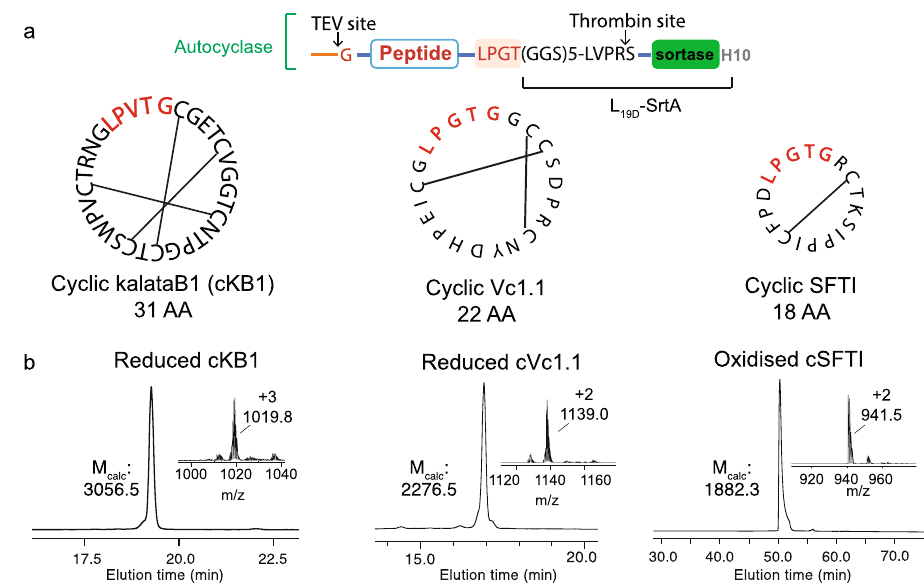
Fig. 4 The production of three different cyclic peptides from autocyclases. a The design of the autocyclases used for producing cyclic SFTI, kalataB1 (kB1) and Vc1.1. The native peptide sequences are shown in black, with lines indicating the disul fi de bond connectivity. The SrtA recognition sequence (LPXTG) that remains in in the peptide after the cyclisation is highlighted in red. b The identity and purity of the cyclised peptides were assessed by rpHPLC and LC/ MS. Observed masses were m/z 1019.8 [M + 3H] 3 + for cKB1, m/z 1139.0 [M + 2H] 2 + for cVc1.1 and m/z 941.5 [M + 2H] 2 + for cSFTI. Calculated masses are m/z 1019.8 [M + 3H] 3 + for cKB1, m/z 1139.3 [M + 2H] 2 + for cVc1.1 and m/z 942.2 [M + 2H] 2 + for